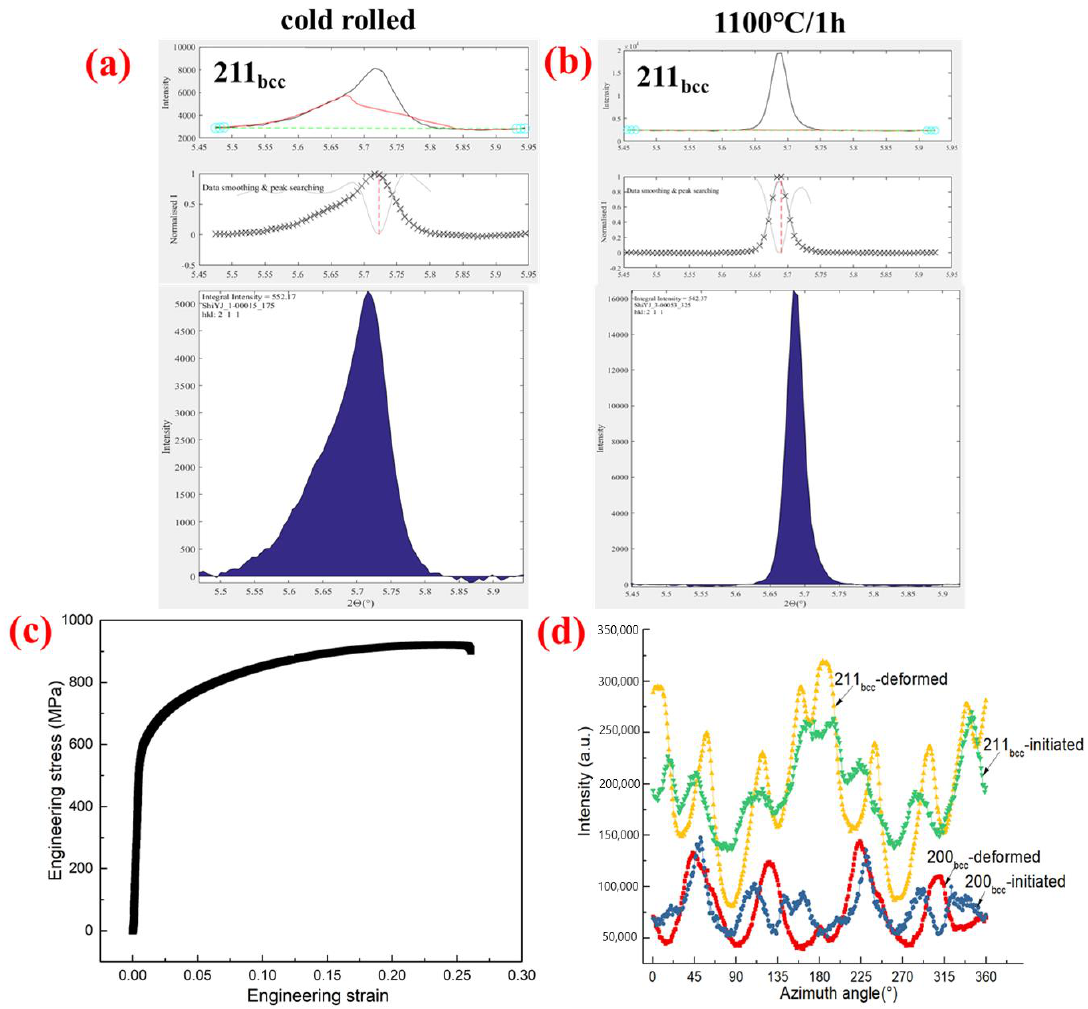
Figure 6. ( a ) Symmetry and ( b ) asymmetry of {211} bcc under cold rolling and at 1100 °C/1 h. ( c ) Tensile engineering stress-strain curve of the FeCoNiCrMnAl 0.5 alloy at room temperature. ( d ) Integral intensity of the {211} bcc and {200} bcc Debye–Scherrer rings along the entire azimuthal angle when the incident beam was parallel to the rolling direction.